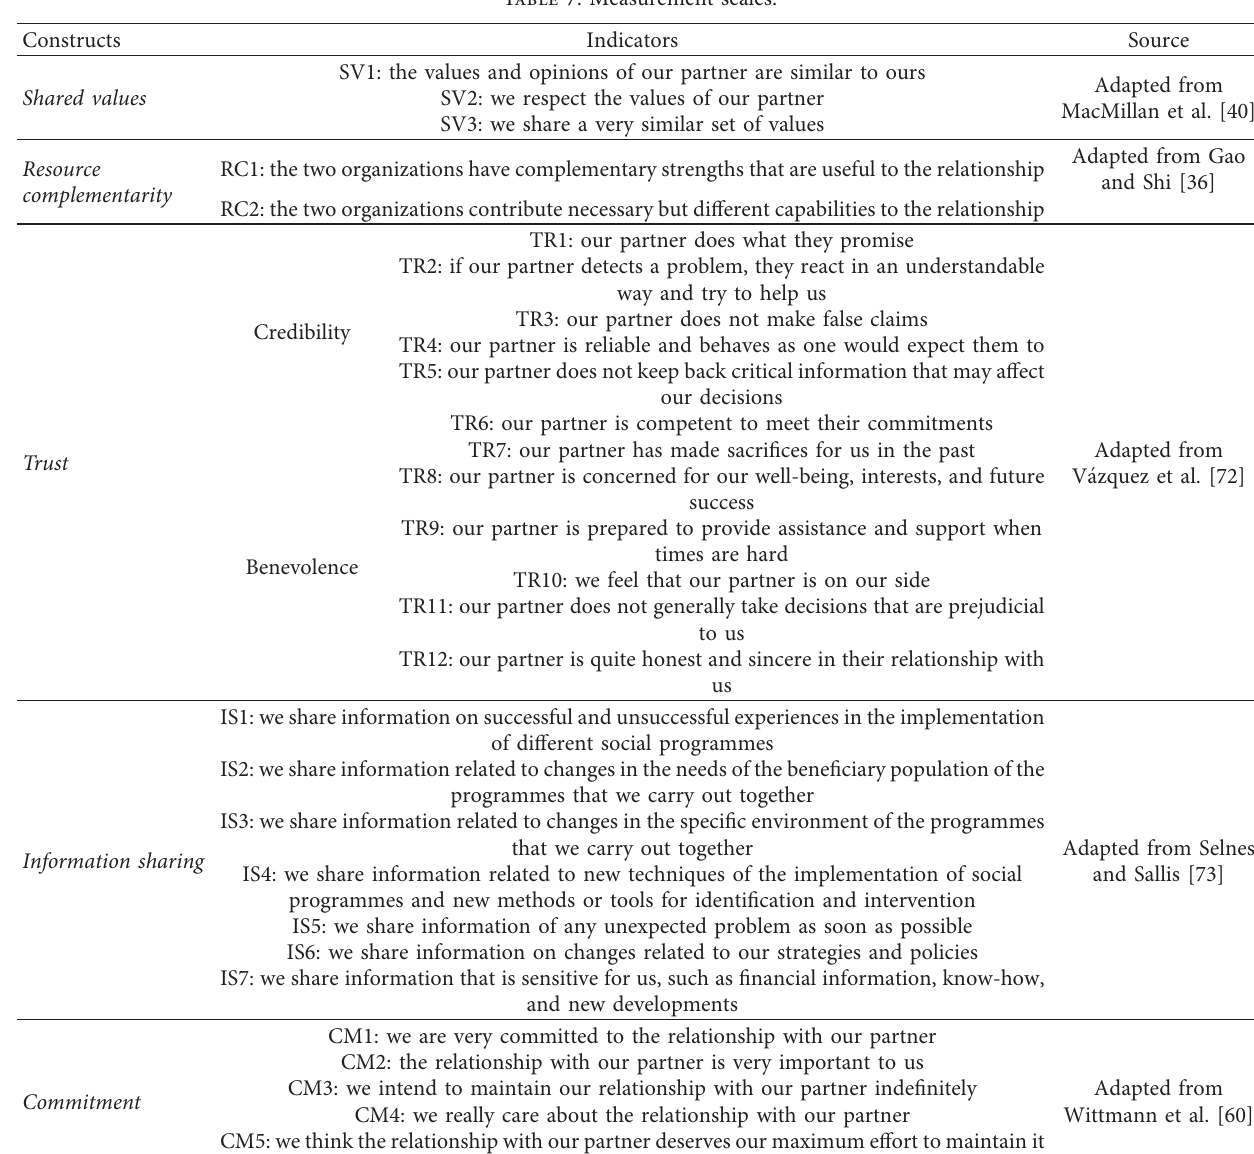
Table 7: Measurement